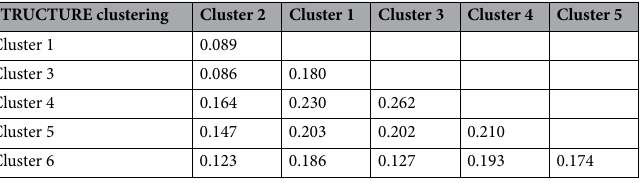
Table 2. Pairwise F ST (genetic differentiation) values among clusters identified by STRU CTU RE